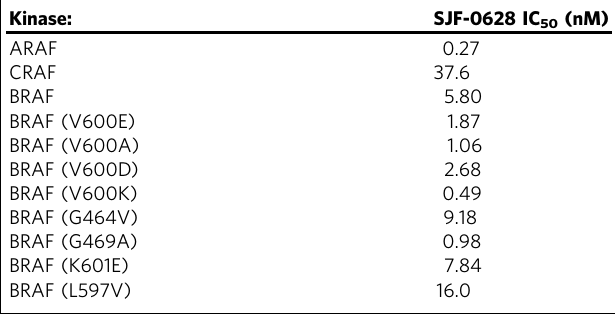
Table 1 Table of IC 50 values from radio labeled kinase assay ( n = 2 biologically independent experiments).